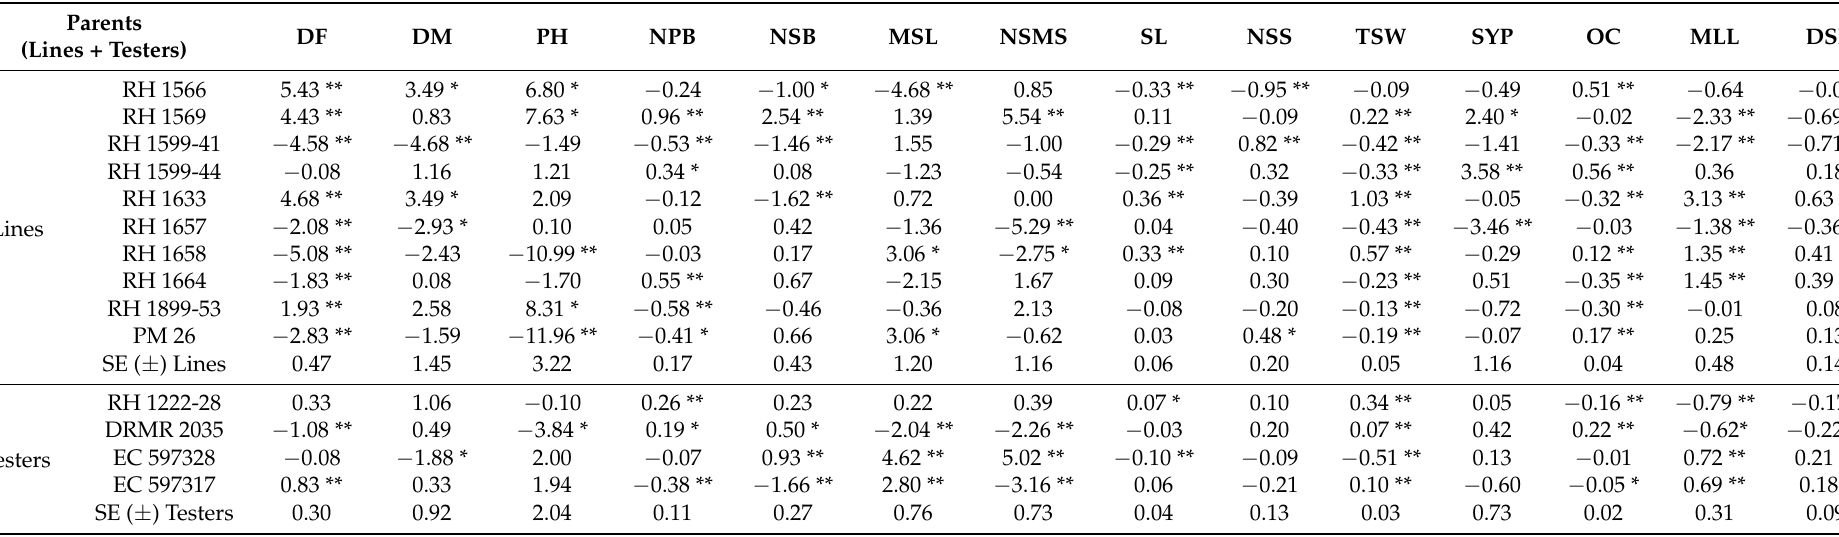
Table 4. General combining ability (GCA) of parents for seed yield and its component traits and Sclerotinia stem rot resistance in Indian mustard.